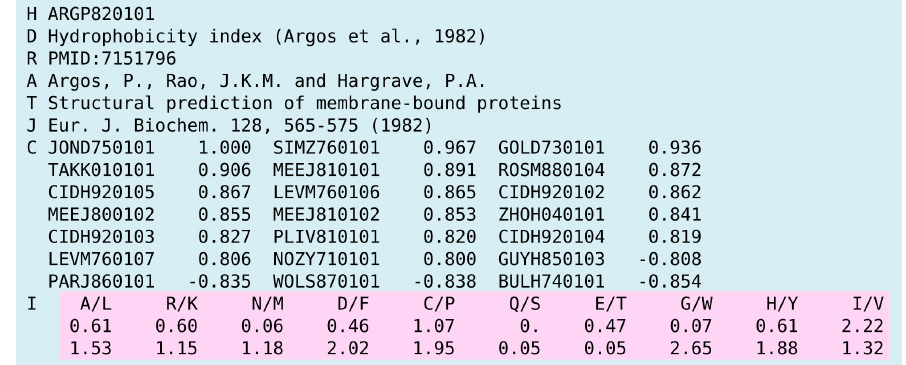
Figure 3. An example of the AAindex1 entry representing the hydrophobicity index. The values assigned to amino acids are highlighted in pink.